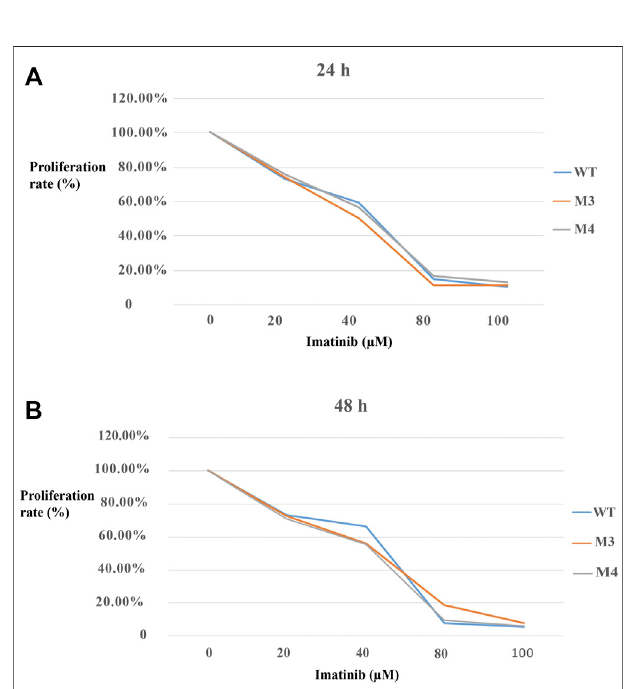
FIGURE 6 | Effects of imatinib at different concentrations (0, 20, 40, 80, and 100 μ M, respectively) on the cell proliferation rate of SK-MEL-28 cells transfected with wild-type (WT) or mutated (M3 or M4) c-KIT. (A) Proliferation ratedecreasedwiththeincrease inimatinibconcentrationwhenthecells weretreatedfor24 h.Theproliferationratewasequaltothepercentage ofthe mean OD from each treated group divided by the mean OD from MOCK. (B) Similar trend was discovered when the cells were treated with imatinib for 48